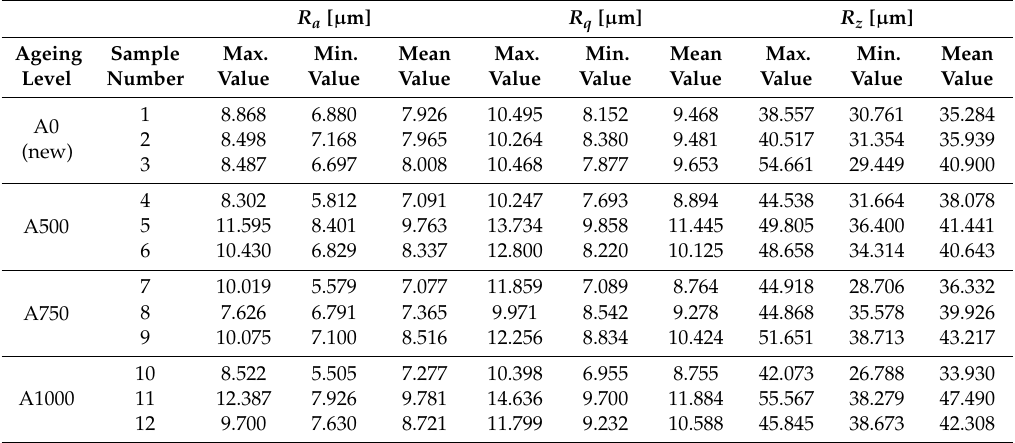
Table 2. T-type J-line connectors. Results of the surface roughness measurements.